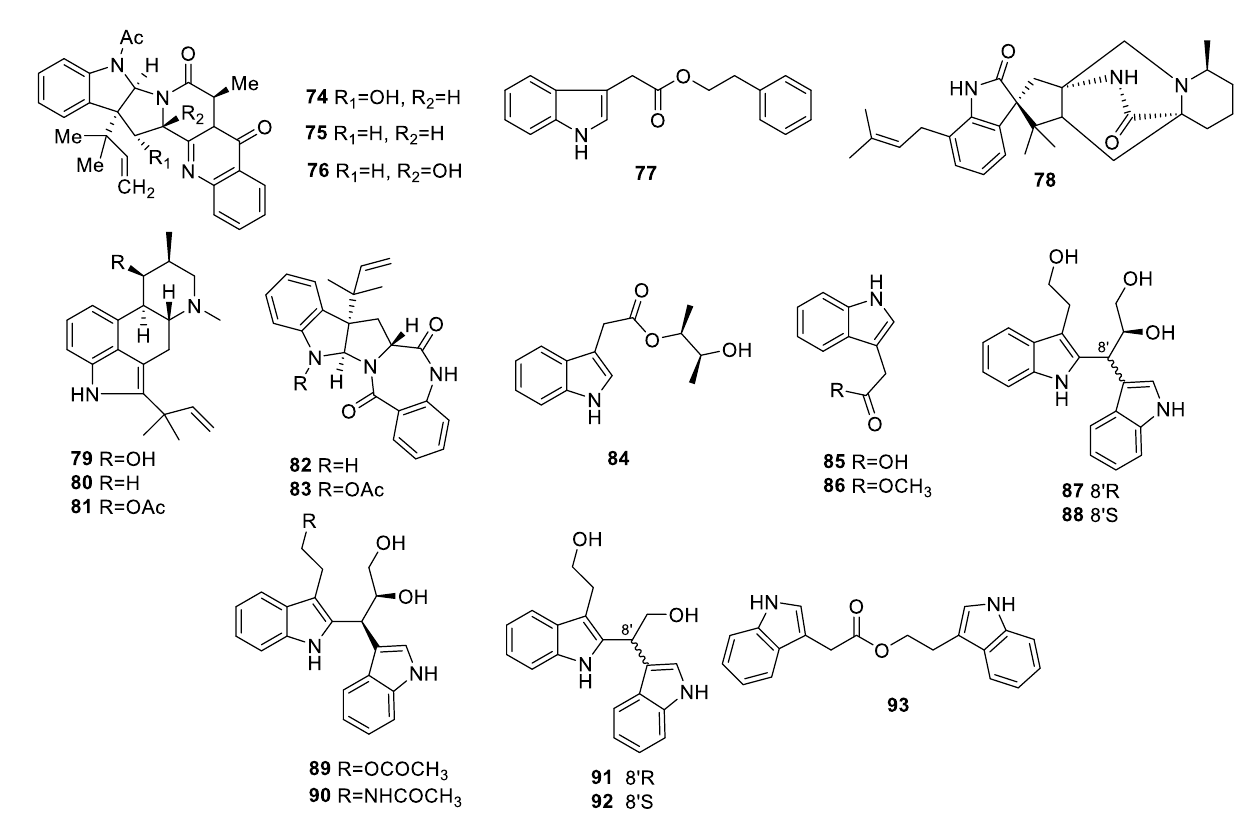
Figure 3. Chemical structures of indole alkaloids ( 74 – 93 ).